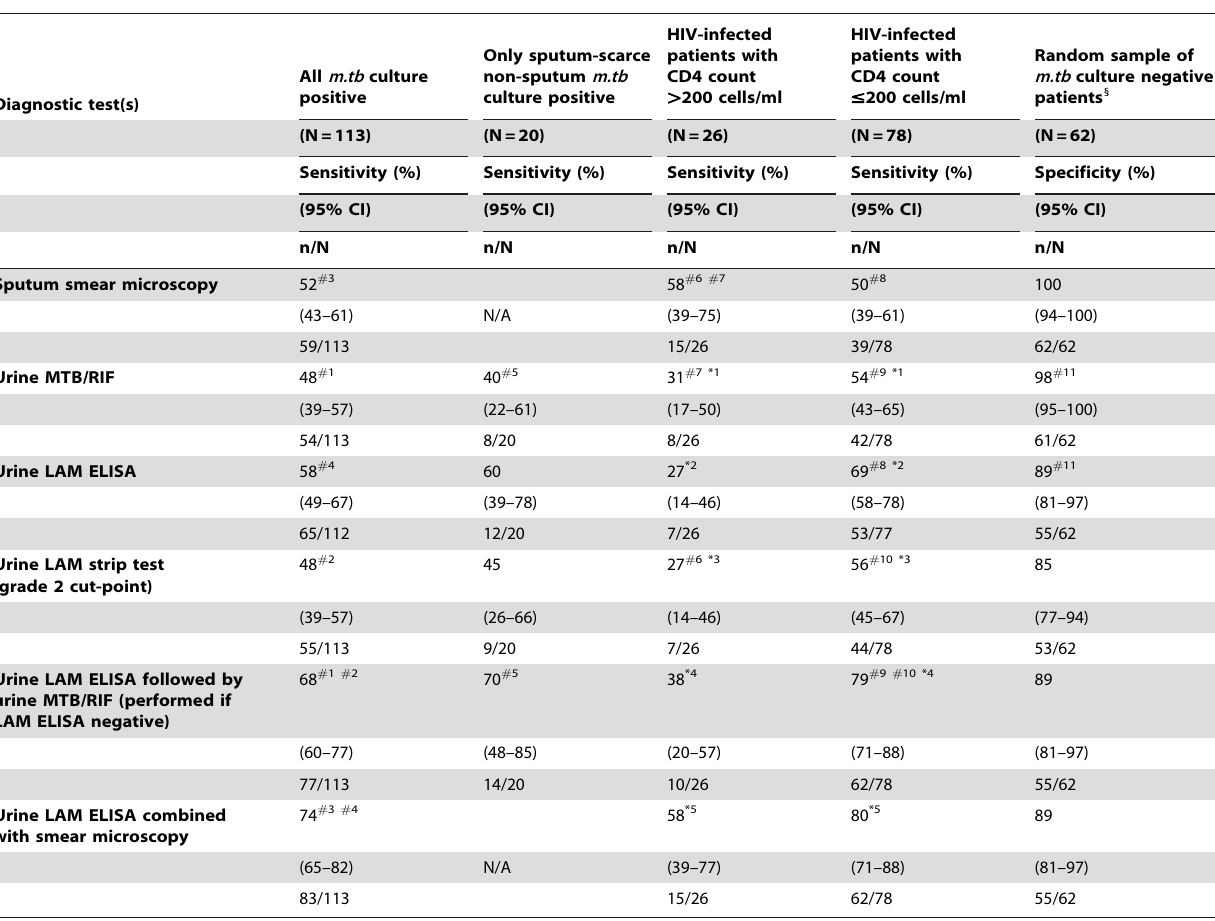
Table 2. Diagnostic accuracy of sputum smear microscopy, urinary MTB/RIF, TB LAM ELISA, LAM strip test (grade 2 cut-point) and clinically relevant combinations thereof in any sputum/non-sputum m.tb culture positive patients overall, in sputum scarce patients only, and stratified by CD4 cell count {